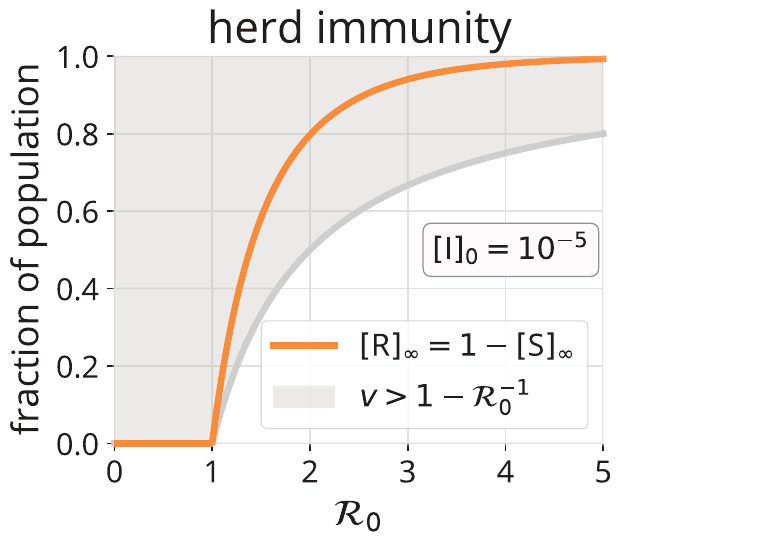
Figure 5 Herd immunity. The gray region shows the fraction v > 1 − R (cid:3) 1 immune to achieve herd immunity, as a function of R 0 . Such immunity could be conferred by vacci- nation and/or by previous infection. For comparison, the orange line shows [R] ∞ , the number of folks that will be infected over the course of an SIR epidemic without any